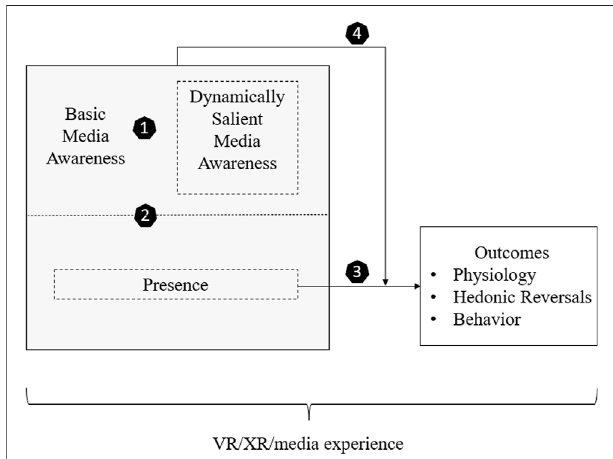
FIGURE 3 | Possible Interconnections between Presence and Media AwarenessandJoint(Interactive)EffectsonOutcomesthatareCharacterizing the Overall User Experience. 1) Media awareness consists of a basic and a dynamically varying part. Basic media awareness is triggered by (conscious) media exposure. Dynamically salient media awareness is triggered by factors outlined in Figure 1 . 2) Media awareness and presence represent two parallel processes during exposure. We assume they might not causally affect each other (yet in the absence of empirical evidence this assumption remains speculative). 3) Presence affects outcomes, i.e., physiological (e.g., arousal), affective (e.g., fear), and behavioral (e.g., approach vs. withdrawal) aspects of the user experience. 4) We assume that basic and dynamically salient media awareness moderate these effects of presence on outcomes. For example, fear might be reversed into pleasurable excitation if media awareness reaches a certain salience level. Hence, users ’ overall media exposure experience needs to be explained based on the interaction of presence and media awareness.